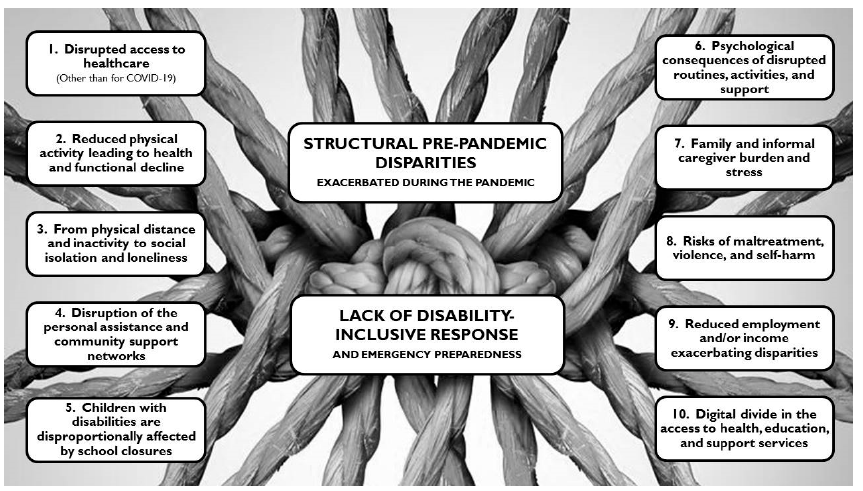
Figure 2. Graphic display of the